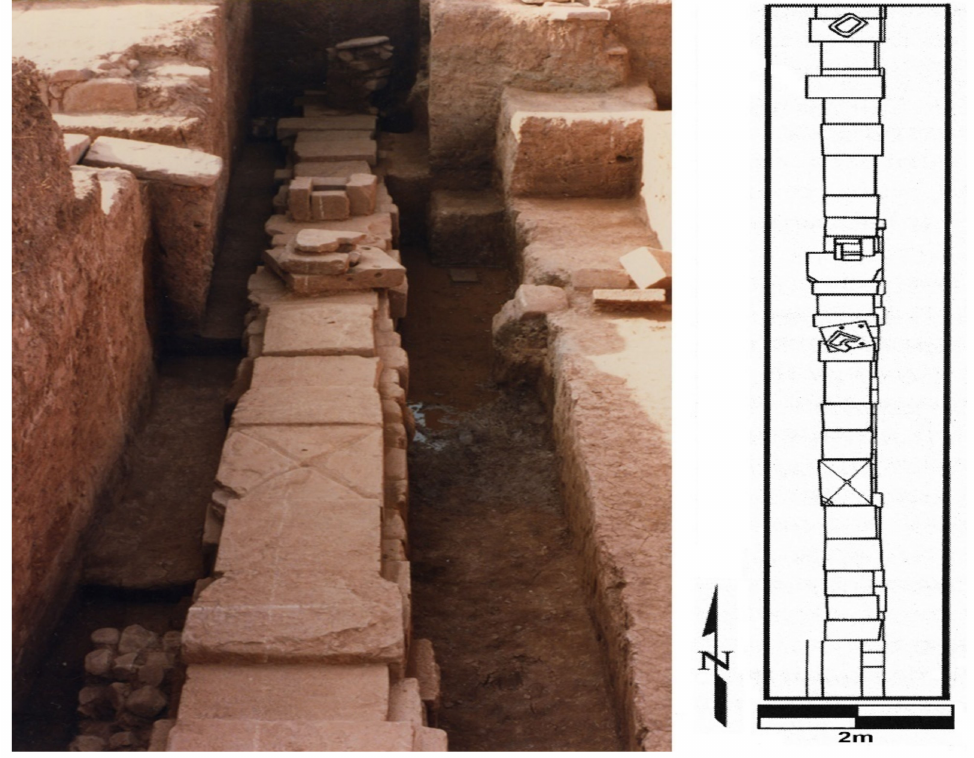
Figure 5. Photo and plan view of the excavated portion of the subterranean channel